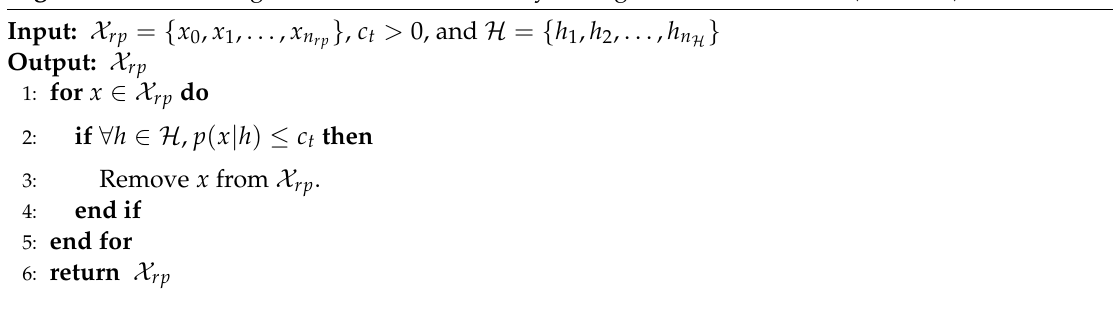
Algorithm 1 Removing Obvious False Alarms by Histogram Mixture Model